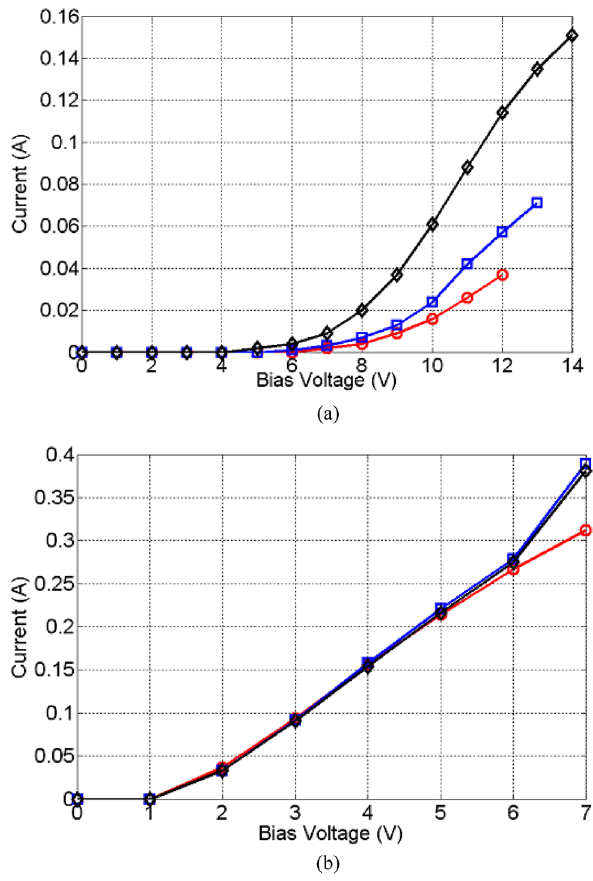
Figure 6. Forward DC bias characteristics of ( a ) NiO and ( b ) TiO 2 for 1 mm (red circles), 2 mm (blue squares) and 5 mm (black diamond)